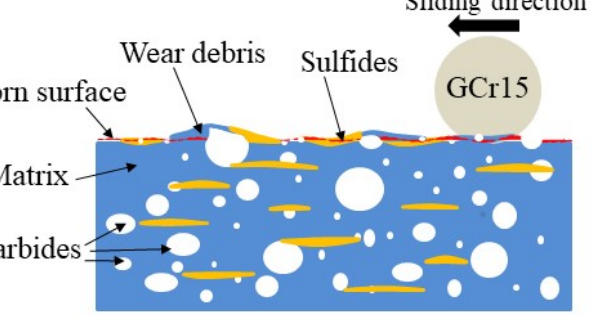
Figure 10. Schematic representation of the precipitation particle (carbides and sulfides) behavior during the pin-on-disc sliding wear test.